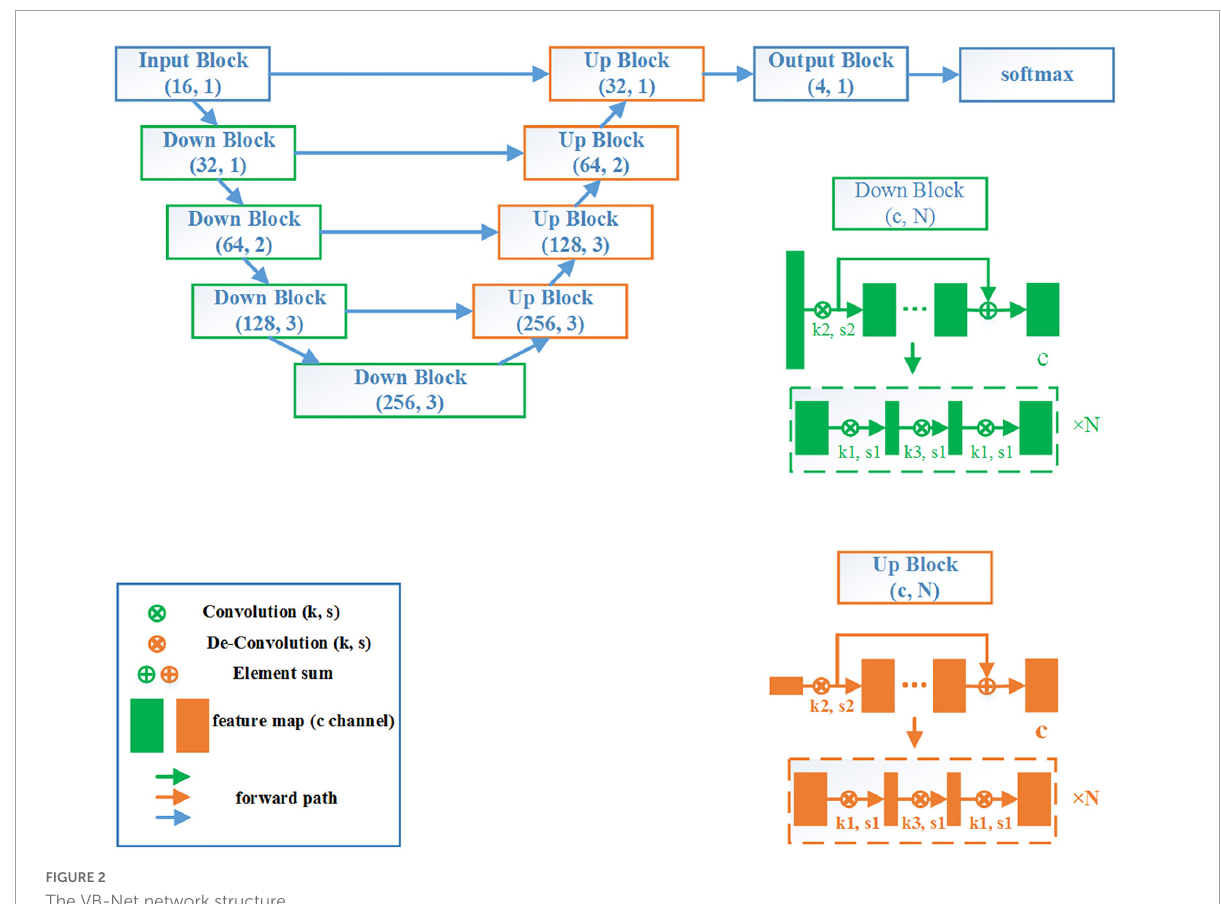
FIGURE2 The VB-Net network structure.